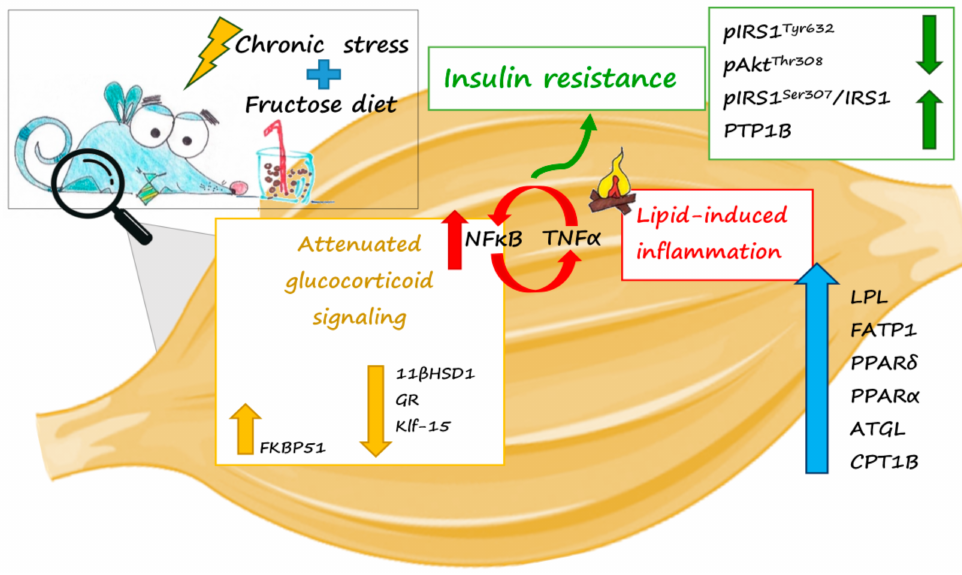
Figure 8. Attenuated glucocorticoid signaling in the skeletal muscle can make a setting for lipid- induced inflammation and the development of insulin resistance in fructose-fed stressed rats. FKBP51—FK506 binding protein, 11 β HSD1—11 β hydroxysteroid dehydrogenase type 1, GR— glucocorticoid receptor, KLF15—Kruppel Like Factor 15, NF κ B—nuclear factor κ B; I κ B—inhibitor of NF κ B; TNF α —tumor necrosis factor α , IRS1—insulin receptor substrate 1, AKT—protein kinase B, LPL—lipoprotein lipase, ATGL—adipose triglyceride lipase, FATP1—fatty acid binding protein 1, PPAR δ —peroxisome proliferator-activated receptor- δ , PPAR α —peroxisome proliferator-activated receptor- α ; CPT1b—carnitine palmitoyltransferase